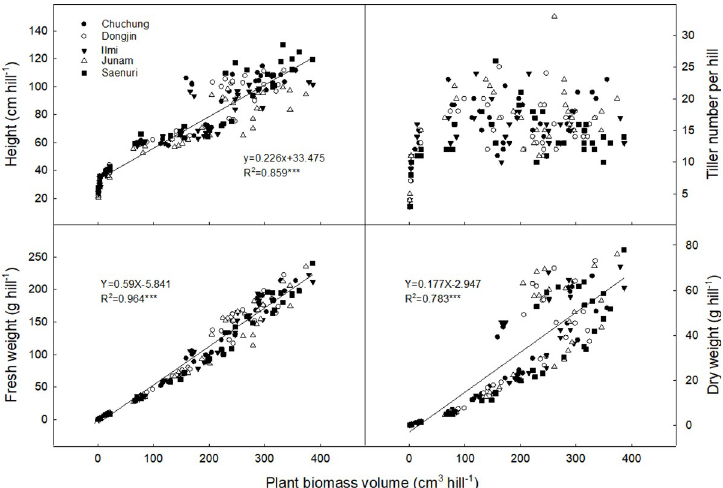
Fig 4. Relationships between rice plant biomass volume and rice growth characteristics during rice cropping period.